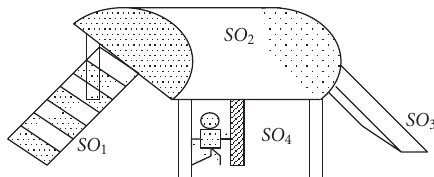
Figure 4: Novel design process modeled by a single channel. follows. To establish an information channel between D ds and D ch via D pl , designers must set an informorphism D ds to D pl . In this case, a designer sets infomorphisms f ∧ ( E 1 ) = O 1 ,